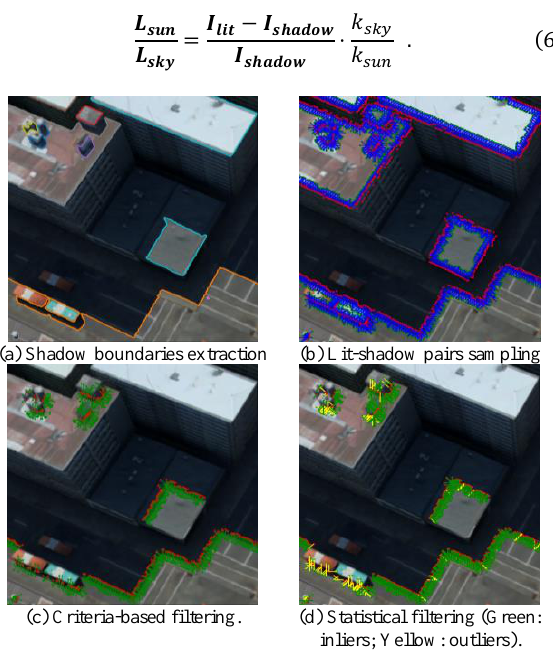
Figure 7. Find reliable lit-shadow pairs to estimate 𝑳 𝒔𝒖𝒏 /𝑳 𝒔𝒌𝒚 .